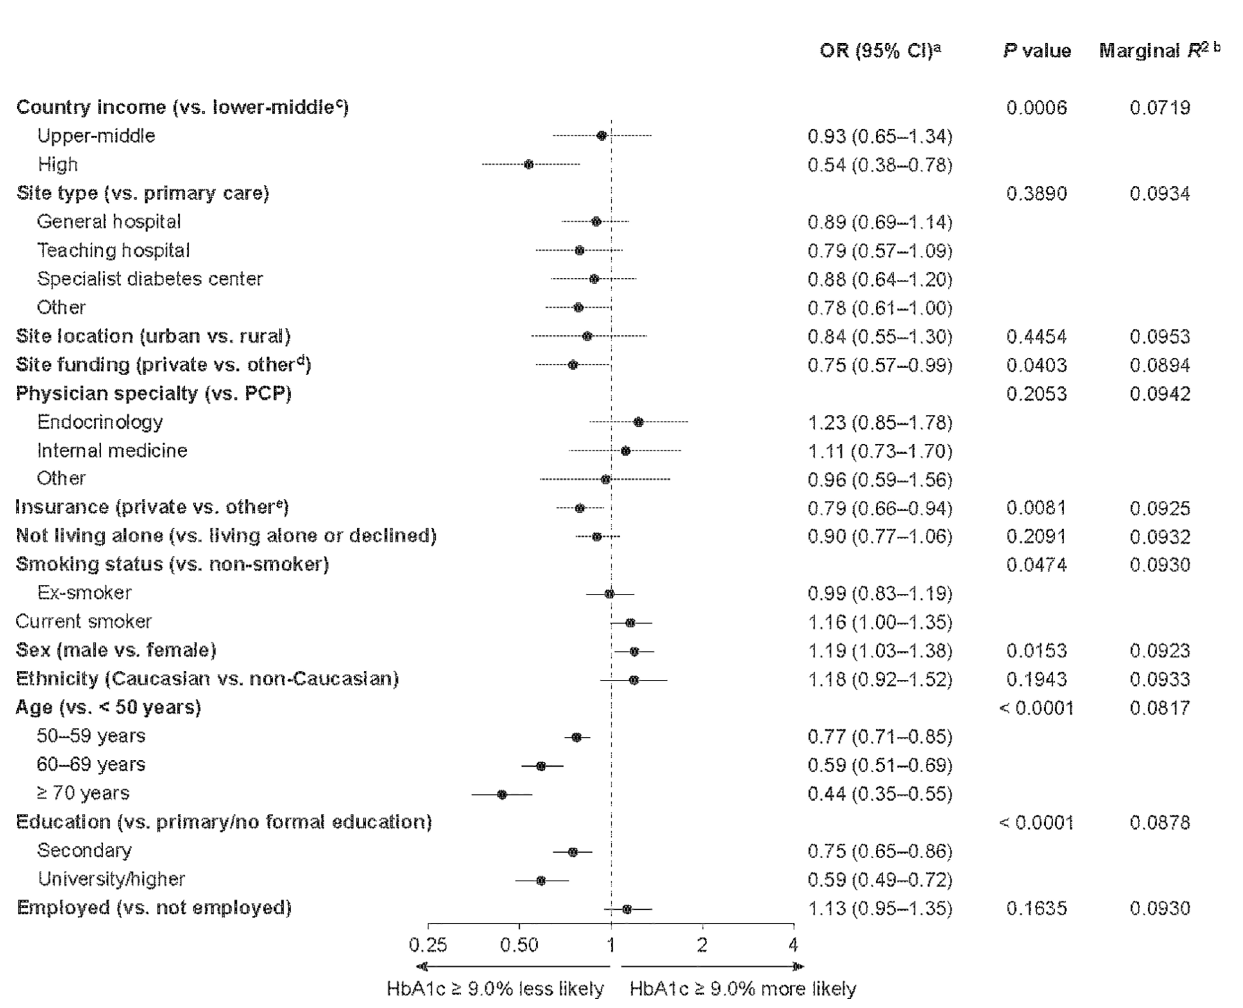
FIGURE 2 | Factors associated with having an HbA1c level ≥ 9.0% among DISCOVER study patients initiating a second-line glucose-lowering therapy. a ORs were calculated using three-level hierarchical models, with patients nested in sites and sites nested in countries and were adjusted for all variables in the fi gure. b Each R 2 was calculated when the corresponding variable was removed from the model. The lower the resulting R 2 value, the more important the removed variable was to the fi t of the model. c Countries were categorized by2015 gross nationalincome per capita into lower-middle-income (US$1,005 – 3,955), upper-middle-income (US$3,956 – 12,235) andhigh-income ( ≥ US$12,236)countries. d Public or governmental,ormixed, funding. e Public, mixed or none. CI, con fi dence interval; HbA1c, glycated hemoglobin; OR,odds ratio; PCP, primarycare